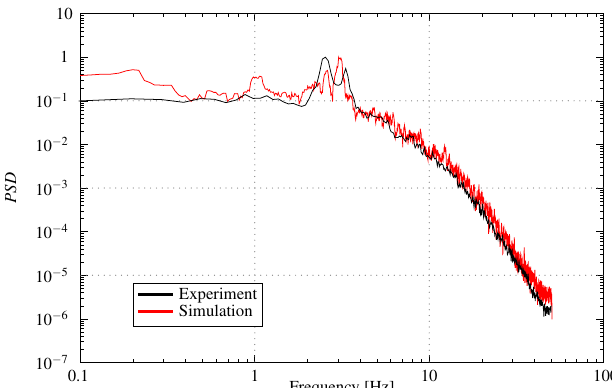
Figure 7. Normalized PSD curves of temperature history in the CFD calculation (blue line) at x = 0.015m, y = 0.09m and z = 0.1m (from STMF −